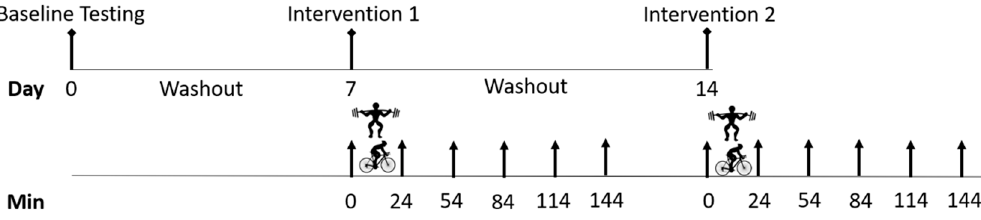
Figure 1. Study protocol schematic. The symbol = high-intensity cycling exercise; = resistance exercise; = blood sample; Min = minutes. The high-intensity cycling exercise and resistance exercise were completed in a random order, with venous blood samples collected immediately before and after exercise, and then every 30 min, for two hours.